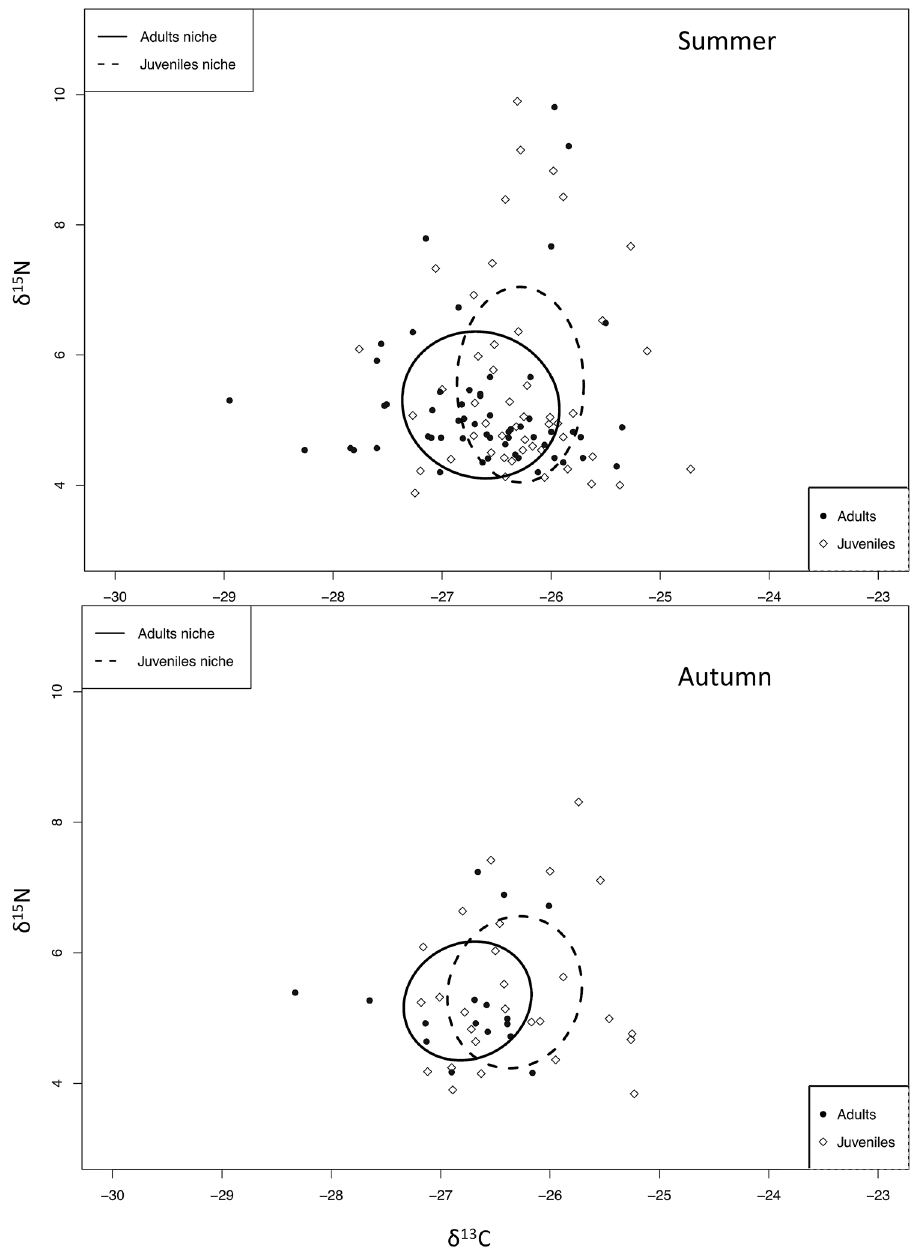
Figure 5. Trophic niche widths of signal crayfish adults and juveniles in summer and autumn estimated by SIBER model ellipses, which represent the feeding niche areas of signal crayfish adults and